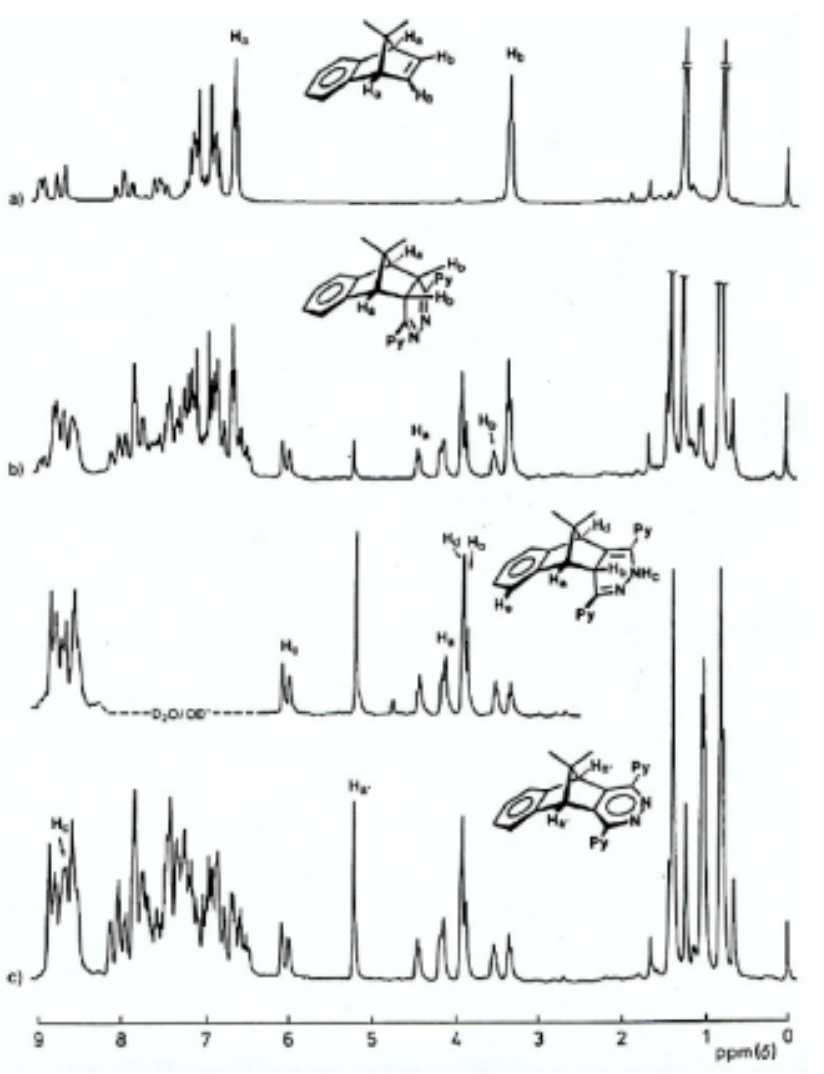
Figure 6. 1 H-NMR spectra (80 MHz; CDCl ) of the 3